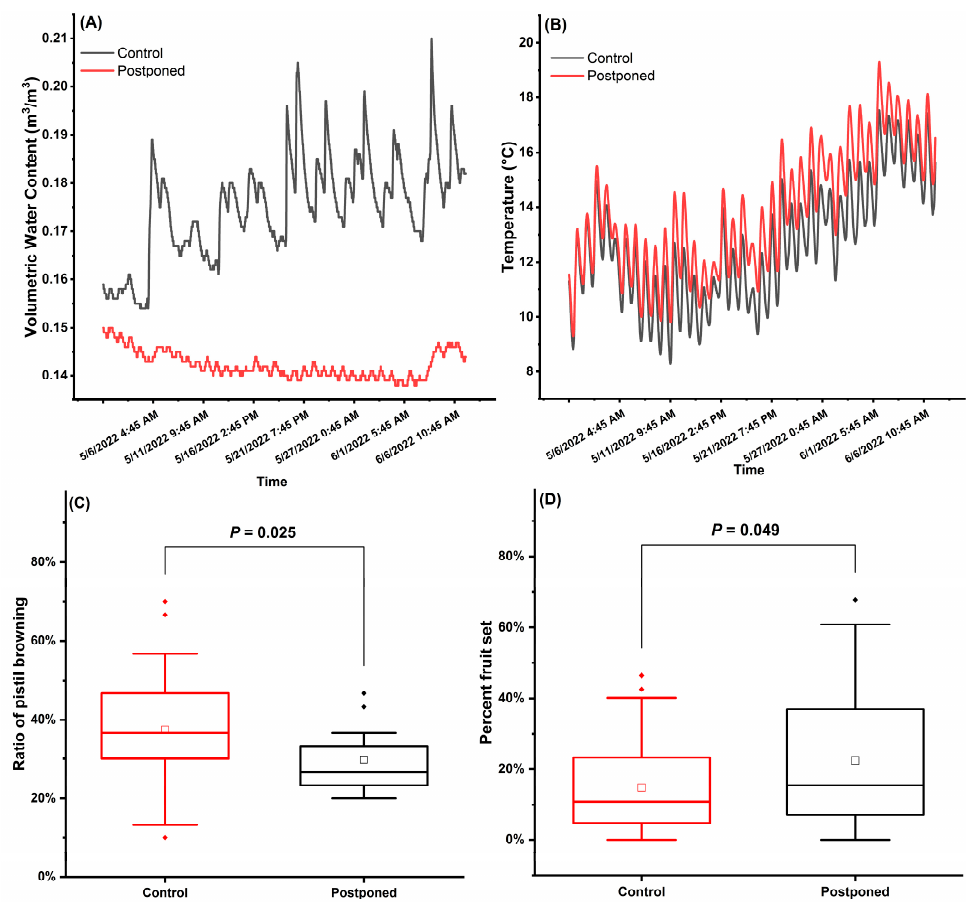
Figure 3. Impacts of FAME on ( A ) pistil browning ratio and ( B ) percent fruit set of ‘Lapins’ sweet cherry in the spring of 2019 at SuRDC1. The early spray (Early) and the late spray (Late) were ap- plied on 7 March and 1 April, respectively. Solid lines in the histograms are distribution curves (n = 18 trees per treatment). Vertical dot lines stand for the mean for each data group.